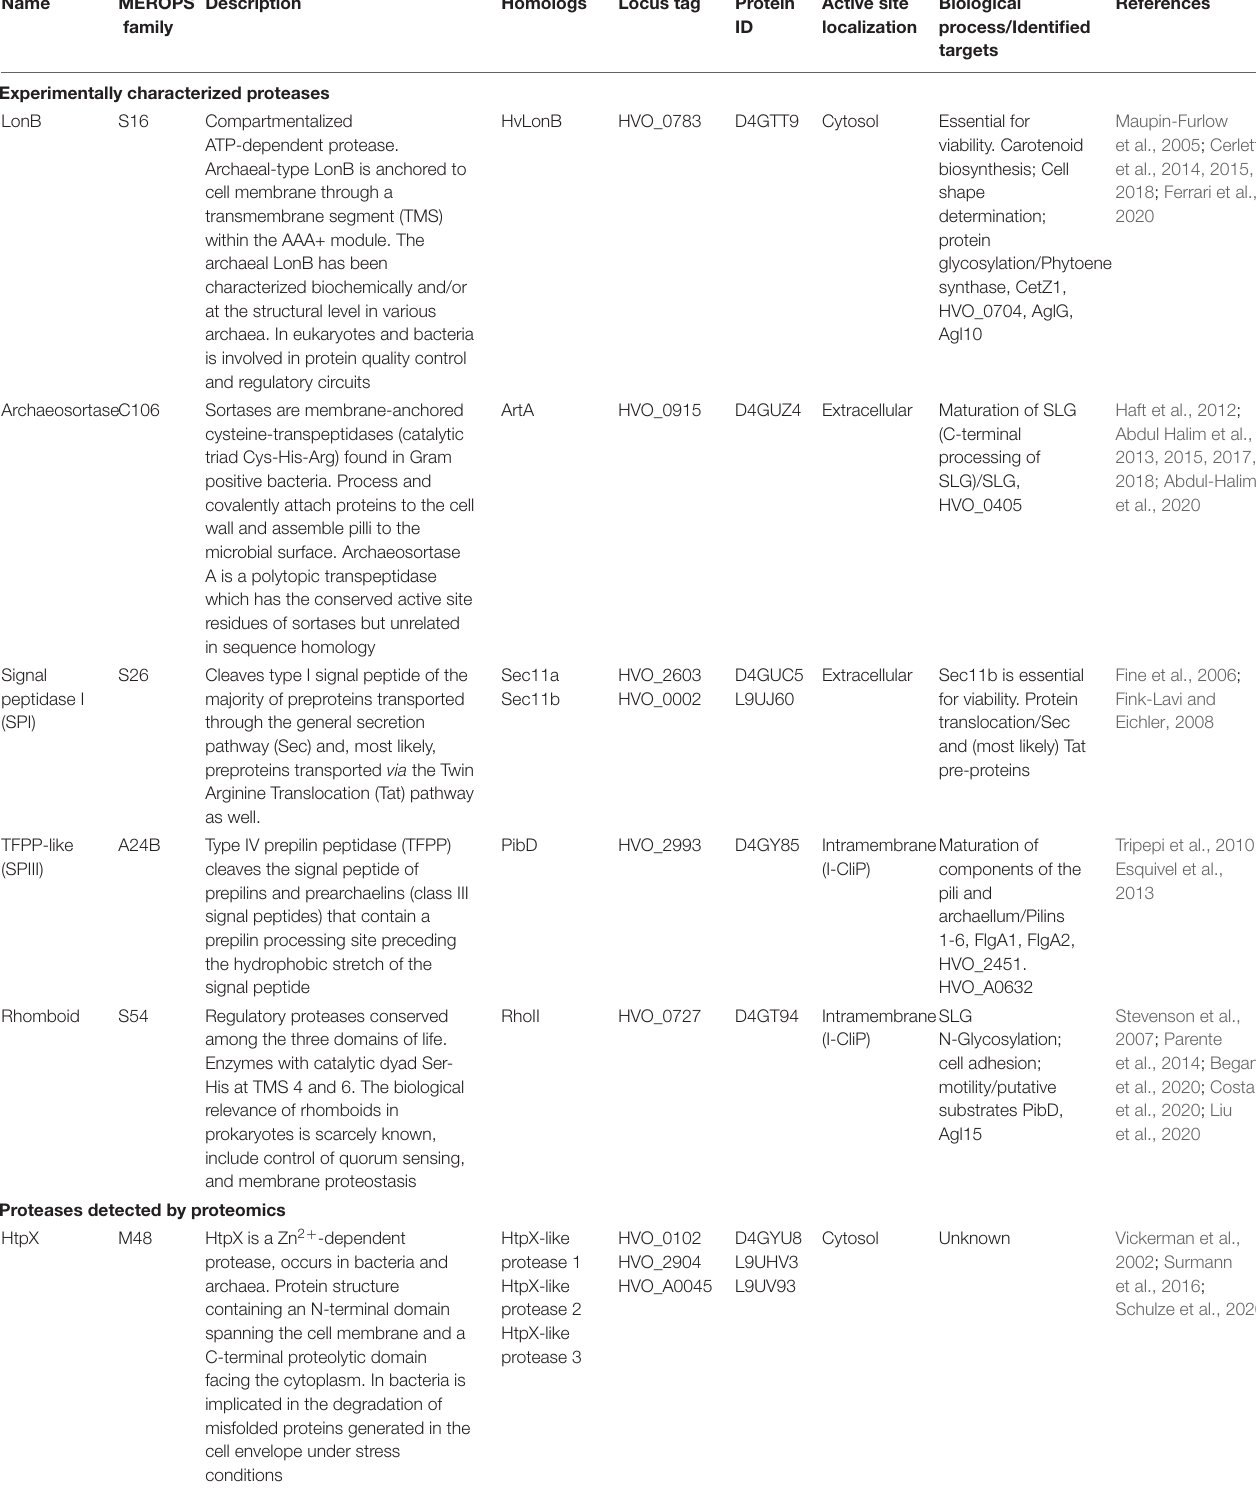
TABLE 1 | Membrane-localized proteases characterized in the haloarchaeon Haloferax volcanii